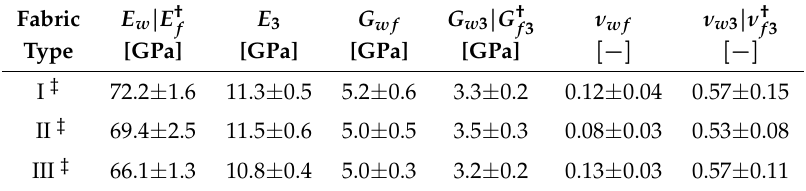
Table A1. Elastic properties of ECC-style fabrics/RTM6-2 composite material ( ¯ φ ≈ 60%).